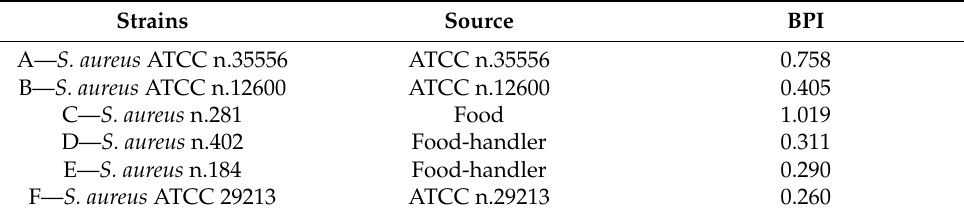
Table 1. Biofilm formation index (BPI) of S. aureus strains on polystyrene at 37 ◦ included in this study. Strains